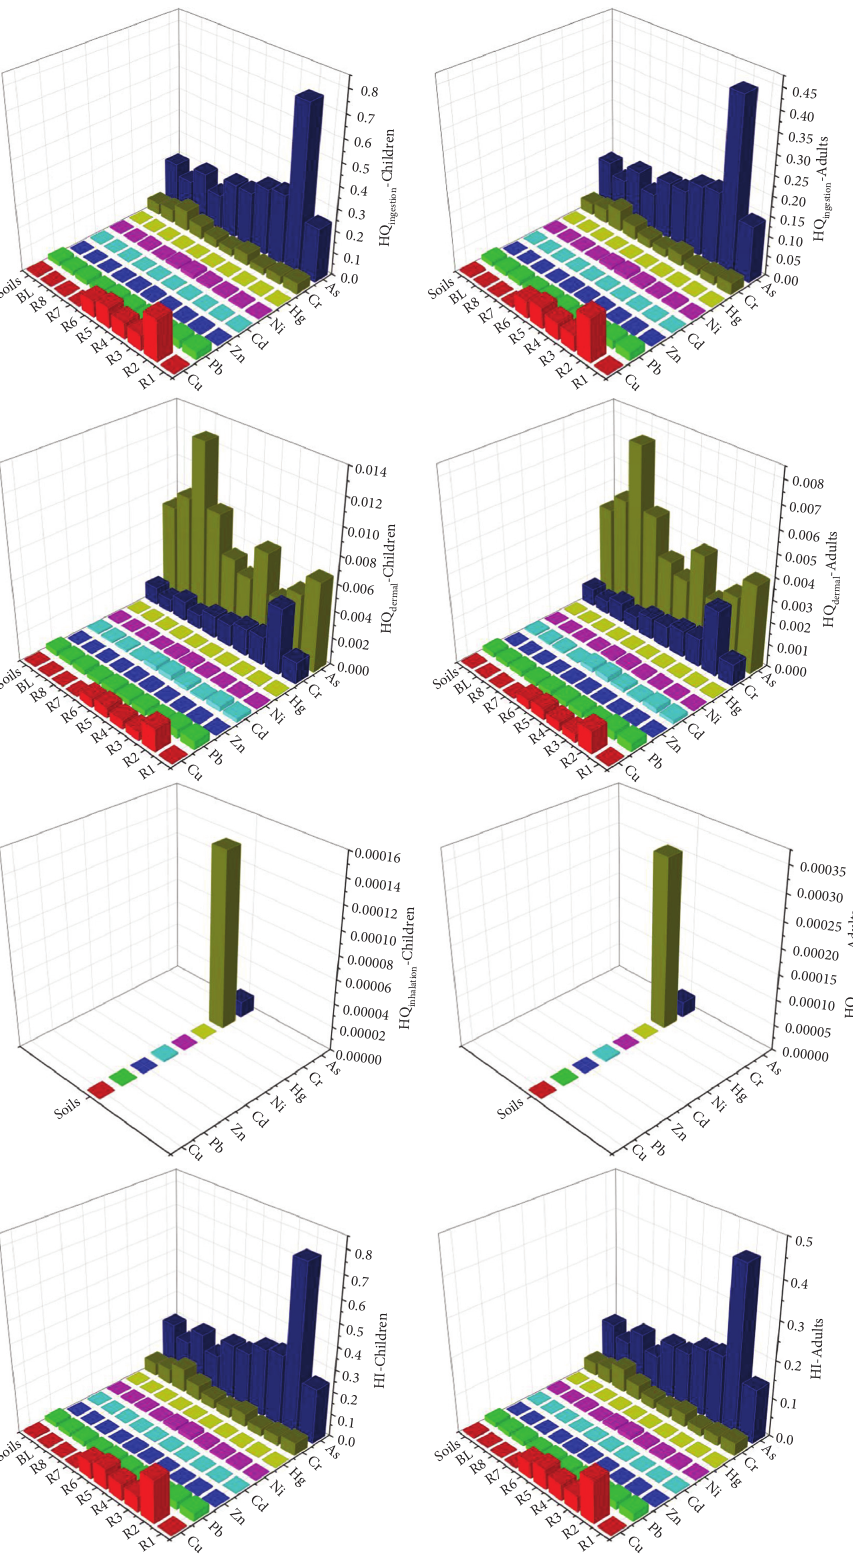
Figure 7: The hazard quotient (HQ) and hazard index (HI) of the study area in sediments and